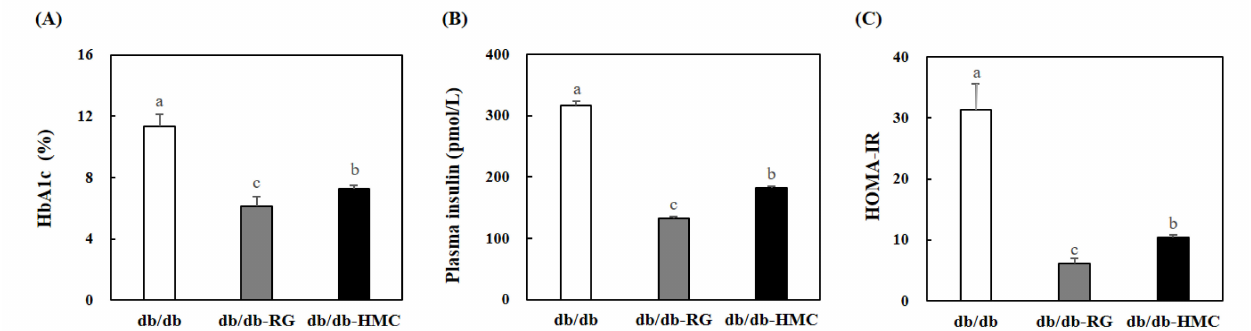
Figure 3. The effects of HMC administration on the levels of HbA1c, plasma insulin and HOMA-IR in C57bL/ksj-db/db mice. ( A ) HbA1c level, ( B ) plasma insulin level, ( C ) HOMA-IR level. Mean ± SD ( n = 8). a–c The mean values that are not indicated by a common letter are significantly different among the groups ( p < 0.05) according to Duncan’s multiple range test. SD, standard deviation. db/db, db/db-RG (5 mg/kg BW per day) and db/db-HMC group (30 mg/kg BW per